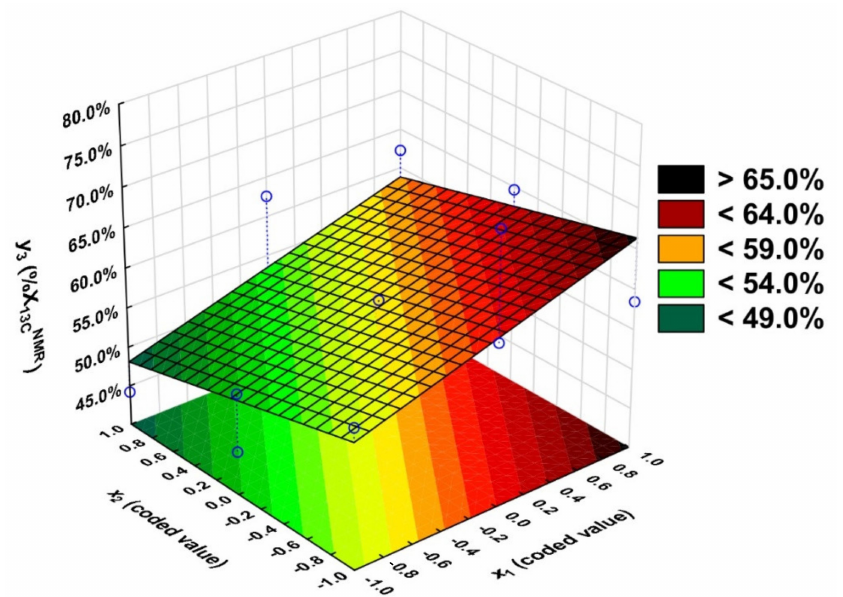
Figure 12. Dependence of itaconic anhydride conversion on the OH/COOH ratio ( x 1 ) and the temperature ( x 2 ), x 3 = 1.